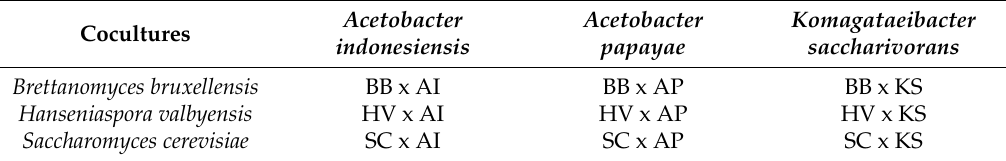
Table 2. “Yeast x Acetic acid bacteria” couples used for cocultures. Cocultures